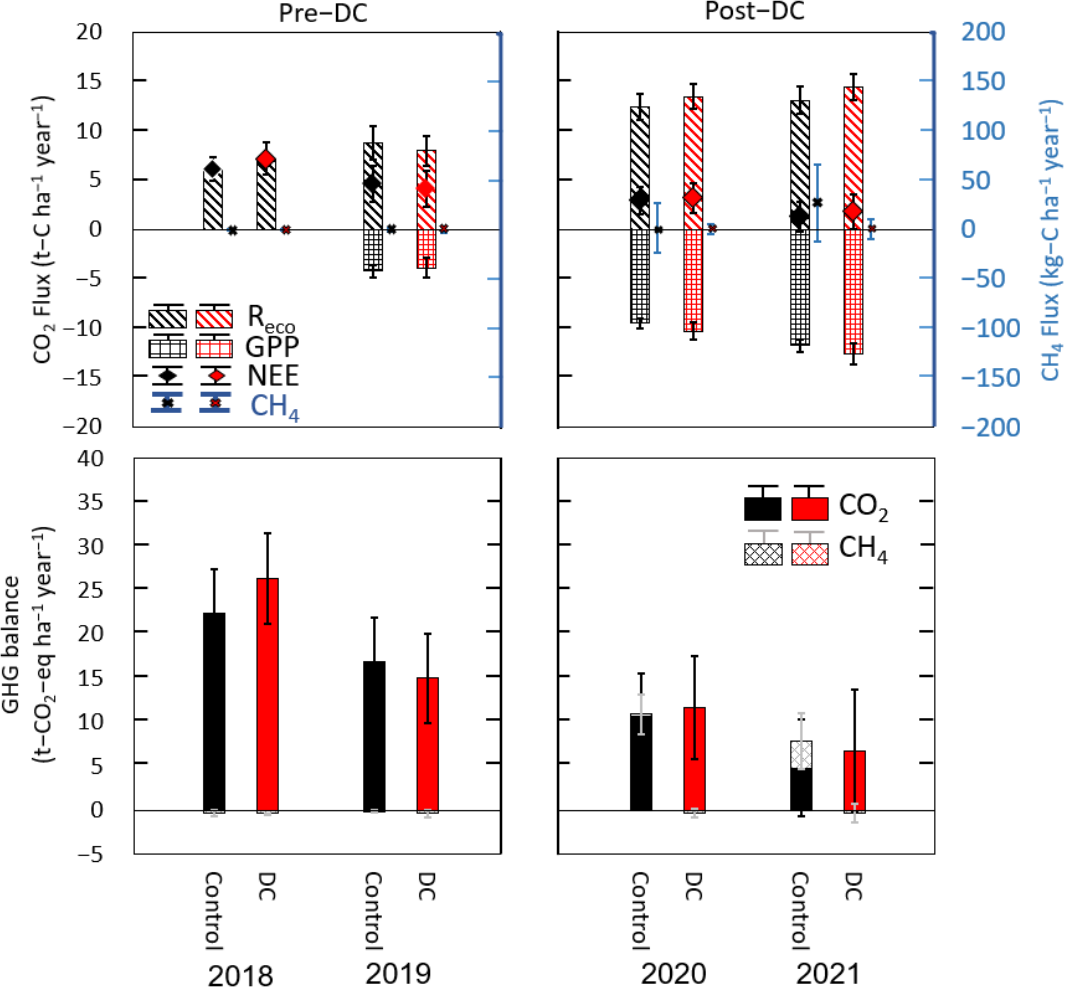
Figure 8. Model estimates for the total annual carbon dioxide (CO 2 ) and methane (CH 4 ) balance (upper panels) and total annual greenhouse gas balance (lower panels) in the control and ditch cleaning treatments areas (DC) during the four study years. CO 2 balances comprise the net exchange (NEE) and its component fluxes of gross primary productivity (GPP) and the ecosystem respiration ( Reco ). Scale of CH 4 flux is at 0.1 times scale of CO 2 flux (blue axis to the right). Greenhouse gas balance of CO 2 and CH 4 uses global warming potentials of 86 for CH 4 over a 20 − year timeframe (IPCC, 2013).